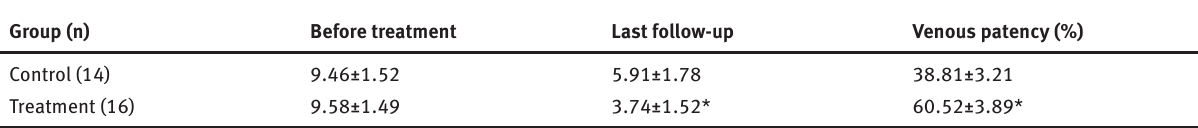
Table 5: Venous patency scores of the patients in each group at the last follow-up Group (n)